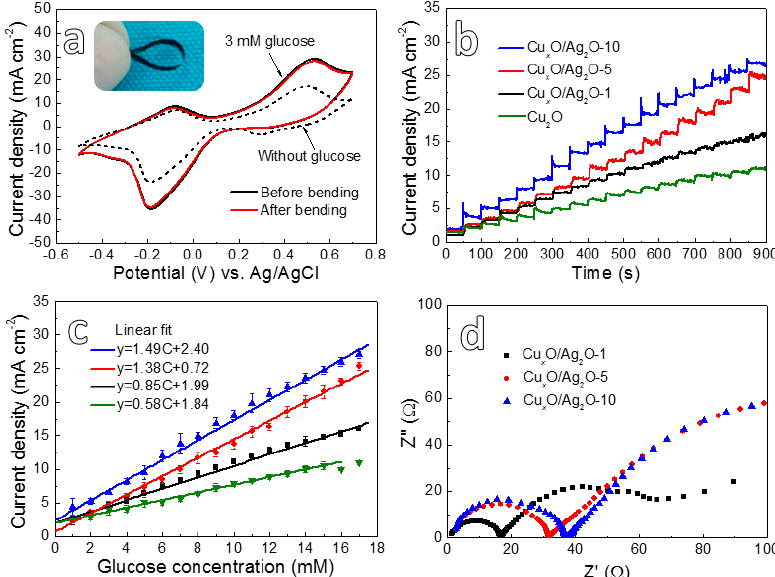
Figure 5. ( a ) The CVs of Cu x O/Ag 2 O-10 in 0.2 M NaOH solution with or without 3 mM glucose over the potential range from -0.5 V and 0.7 V at a scan rate of 20 mV s − 1 with the photo of electrode after bending; ( b ) amperometric i-t curve of Cu x O/Ag 2 O@NP-CuAg electrodes with successive additions of 1 mM glucose into 0.2 M NaOH solution at an applied potential of 0.5 V; ( c ) the corresponding glucose calibration curves for ( b ); ( d ) EIS of the samples anodized for different time in 0.2 M NaOH with 1 mM glucose.